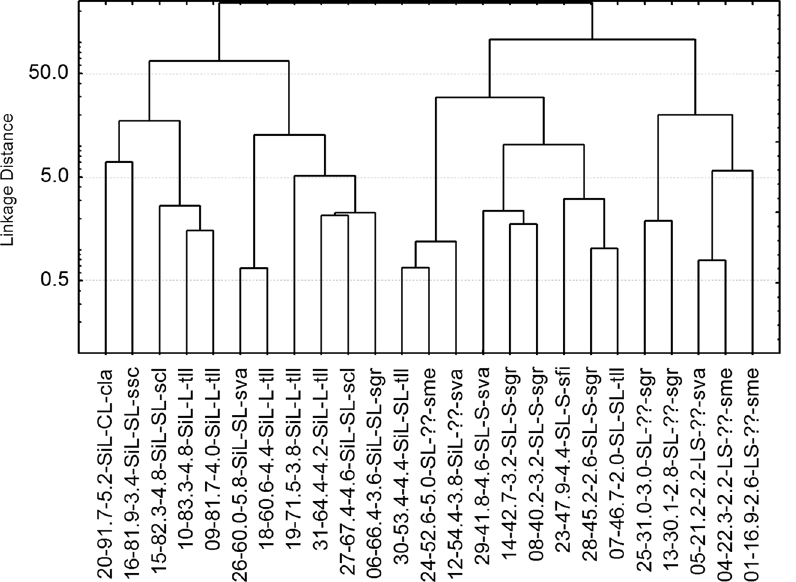
Figure 4: Four LGs of sites distinguished using T approach for site classi fi cation. The number after the fi rst dash indicates the average FIF ( % ) ; after the second dash it indicates the median LOI ( % ) in the site. The codes after the third dash indicate the WRB textural class [ 19 ] according to average percentages of SAF, SIF and CLF determined by laser di ff raction in sites: LS – loamy sand ( number of sites n = 3 ) , SL – sandy loam ( n = 9 ) and SiL – silt loam ( n = 13 ) . The code after the fourth dash indicates WRB textural class [ 19 ] corresponding to that in the soil database for the soil parent material: ?? – no information ( n = 7, L0 ) , S – sand ( n = 5, L2 ) , SL – sandy loam ( n = 7, L3 ) , L – loam ( n = 5, L4 ) and CL – clay loam ( n = 1, L4 ) . The code after the fi fth dash indicates the lithology of the Quaternary deposits ( Figure 1 )